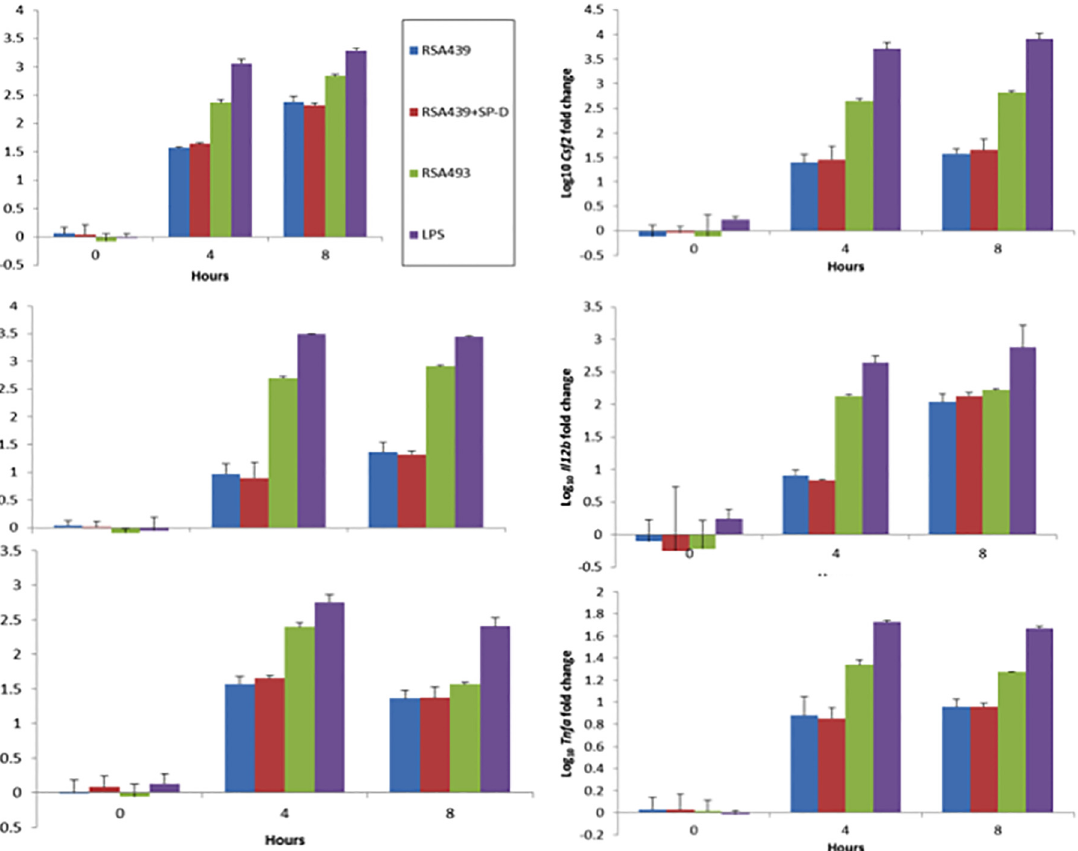
Fig 5. SP-D treatment does not alter C . burnetii stimulated transcriptional patterns in MH-S cells. MH-S cells were infected with PBS or SP-D treated C . burnetii RSA439 (phase II), RSA493 (phase I) or treated with E . coli LPS for 0, 4, and 8 hours. RNA was extracted as described and applied to real-time PCR. Data represent the mean ± standard deviation of fold change in RNA expression of select genes compared to expression of host cell Gapdh , n = 3. RSA439 and LPS data are representative of three independent experiments, RSA493 data are representative of two independent experiments. Student t- tests compare each time and condition to its corresponding 0 time point, all RSA439 and RSA439 + SP-D were significantly up-regulated * p < 0.05. There was no significant difference in expression between untreated and SP-D treated C . burnetii RSA439 as determined by student